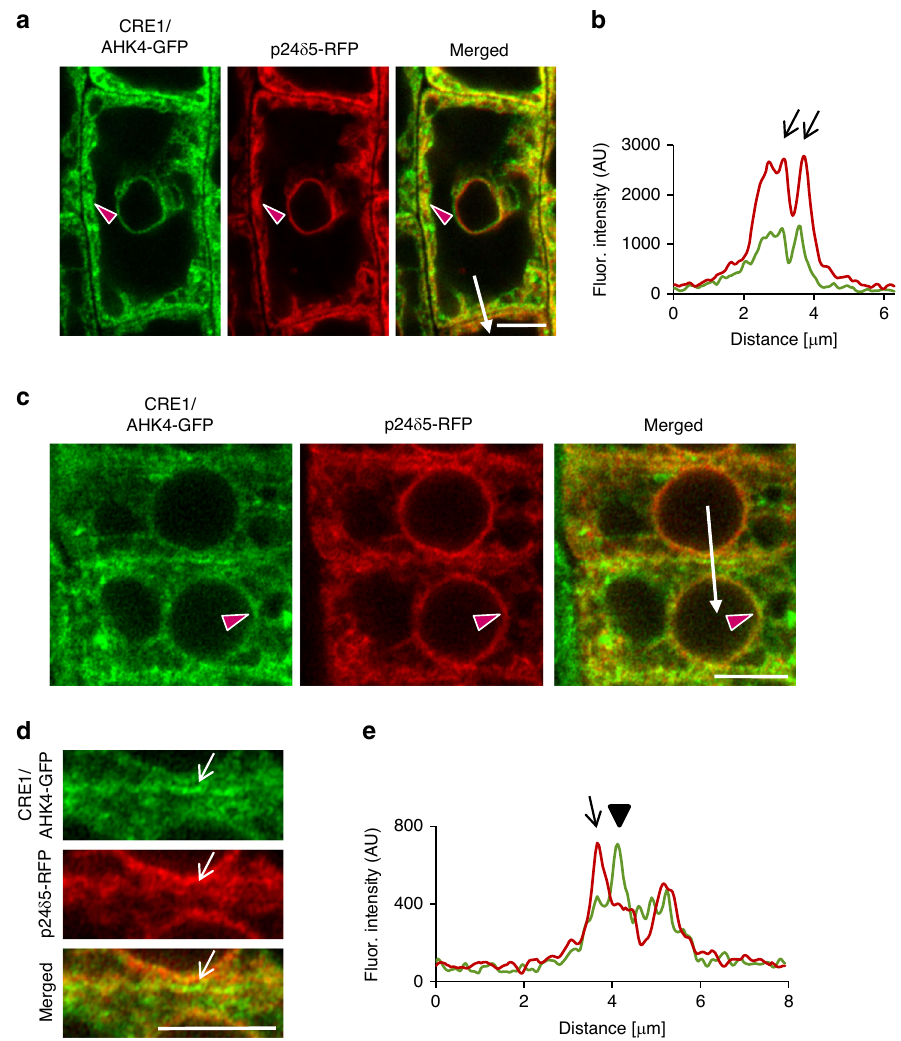
Fig. 3 CRE1/AHK4-GFP subcellular localization in cells of Arabidopsis root. a – e Monitoring of CRE1/AHK4-GFP cytokinin receptor (green) and ER- marker p24 δ 5-RFP (red) in LRC cells ( a , b ) and root meristematic epidermal cells ( c – e ). Red arrowheads mark areas of co-localization. Fluorescence intensity pro fi les of the ER marker (red line) and CRE1/AHK4-GFP (green line) ( b , e ) were measured along the white lines ( a , c ) starting from upper end (0 µ m) towards the arrowhead. Peaks of p24 δ 5-RFP fl uorescence maxima at the endoplasmic reticulum overlap with CRE1/AHK4-GFP signal maxima in the LRC cells and root meristematic epidermal cells (black arrows; b , e ). Peak of CRE1/AHK4-GFP non-overlapping with peaks of p24 δ 5-RFP in the root meristematic epidermal cells indicates localization at the plasma membrane (black arrowhead; e ). Detailed view ( d ; white arrows point to CRE1/AHK4-GFP signal at the area of the PM). Scale bars = 5 μ